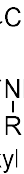
Figure 1. The general structure of 2-amino-3-cyanopyridines.